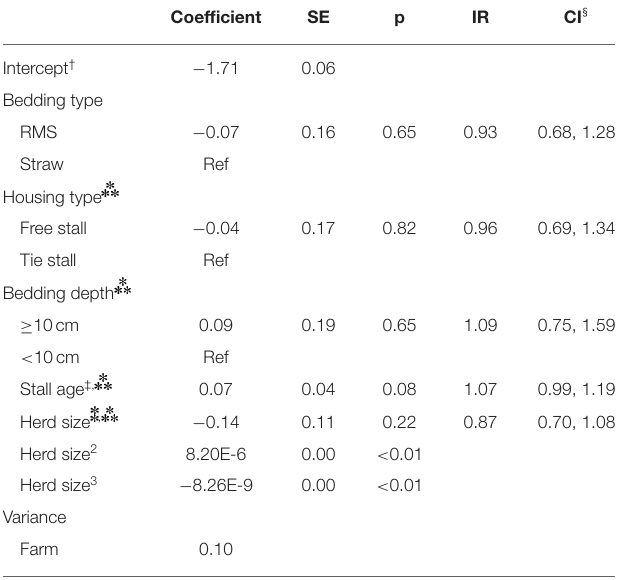
TABLE 3 | Impact of bedding type on the risk of a DHI test with a linear score > 4.0 in 11,031 cows from 20 RMS farms and 60 straw-bedded farms and estimated using a generalized linear mixed